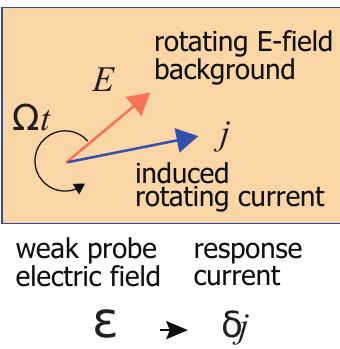
Figure 1. Setup for the holographic calculation. In the steady state, the rotating electric (cid:12)eld E within the ( x; y )-plane induces a retarded rotating current j in the ( x; y )-plane. In addition to E , a weak non-rotating electric (cid:12)eld " is applied. This (cid:12)eld induces a current (cid:14)j linear in " .